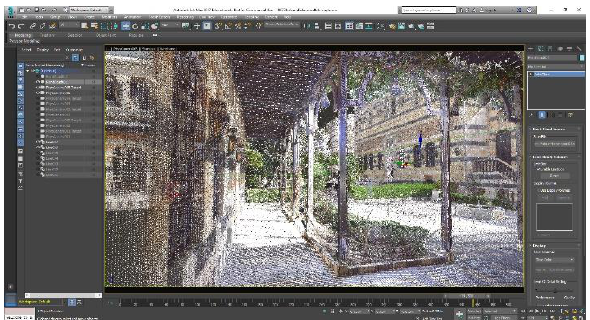
Figure 9. Al-‘Azm Palace – Autodesk 3Ds